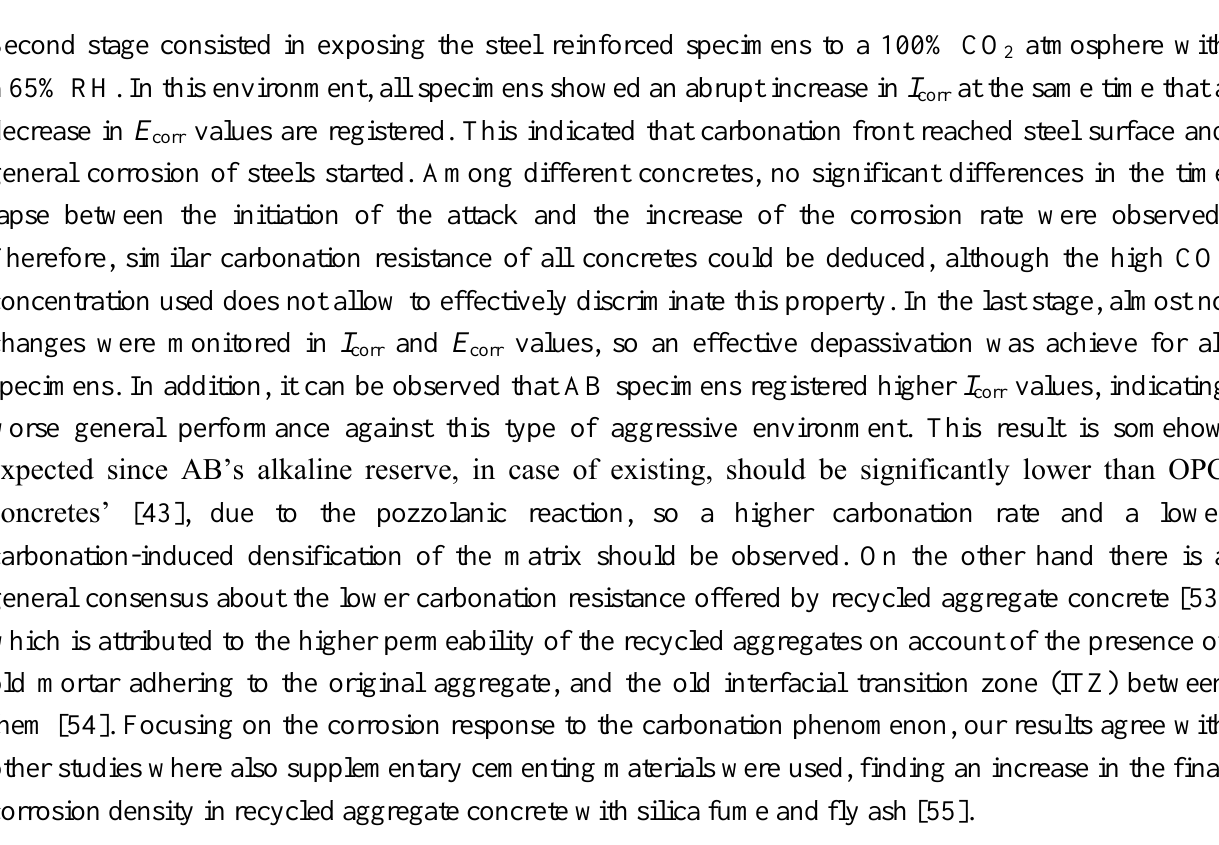
Figure 10. Corrosion rate and corrosion potential of steel reinforcement embedded in different concretes under sea water